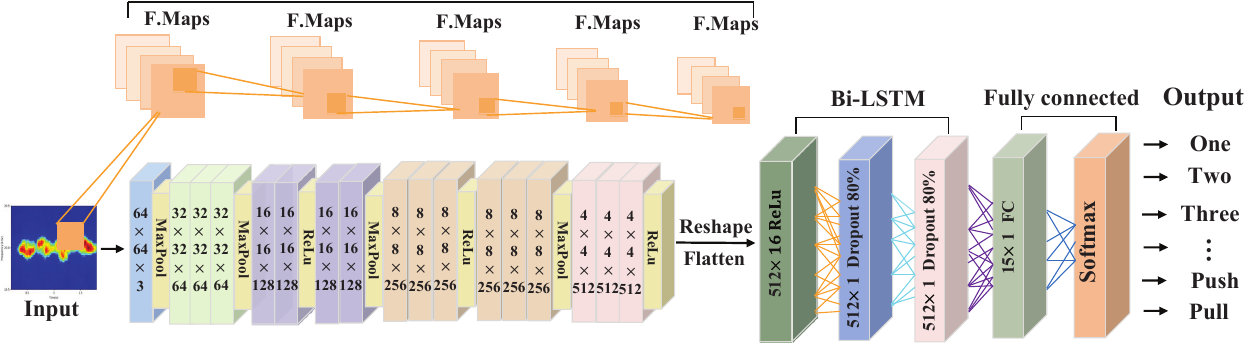
Figure 7. Overview of the ResNet34 and